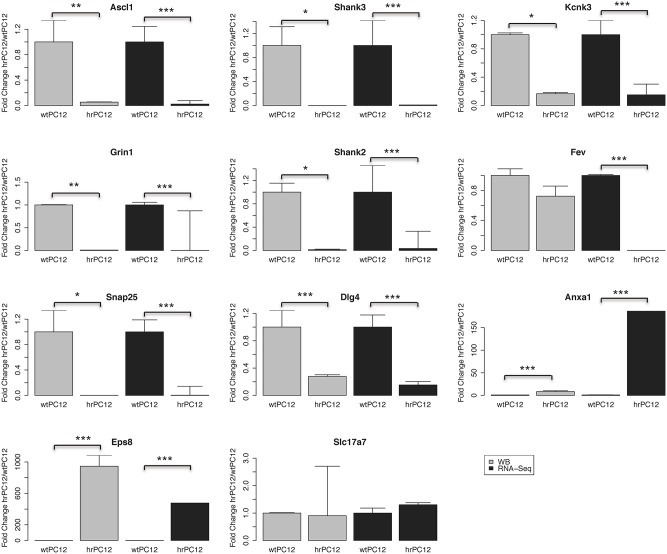
Quantification of the western blot data of Figure 3. The proteins encoded by 9 out of 11 genes: 7 down-regulated, 1 unchanged, and 1 up-regulated, exhibit levels parallel to the RNA-Seq values. Annexin 1 (Anxal) exhibits a significant up-regulation, however less marked than the up-regulated gene expression shown by RNA-Seq. The transcription factor protein Fev appears unchanged whereas its gene expression is strongly repressed. Mean fold change values are shown ± standard deviation. Western blot replicates employed ranged from 2 to 4. Statistical analysis was carried out by a paired t-test. For the RNA-Seq analysis, the adjusted p-value of the negative binomial (DESeq) was used. (*p < 0.05, **p < 0.01, ***p < 0.001).